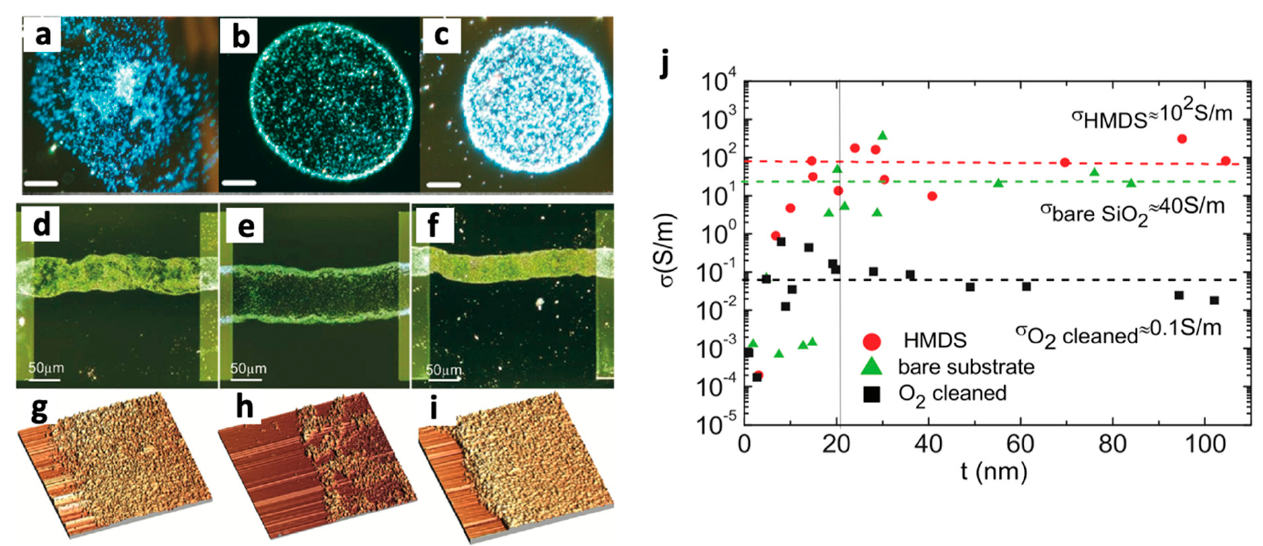
Figure 2. Dark-field optical micrograph of inkjet-printed drops on ( a ) plasma-cleaned, ( b ) pristine, and ( c ) HMDS-treated substrate. Scale is 20 μ m. Optical micrograph of inkjet-printed stripes on ( d ) pristine, ( e ) O 2 -treated and ( f ) HMDS-treated substrates. AFM images of ( d – i ), respectively. ( j ) Conductivity ( σ ) as a function of thickness for HMDS-coated, O 2 -plasma- treated and pristine substrates. Reprinted with permission from Ref. [45]. Copyright 2012 American Chemical Society.